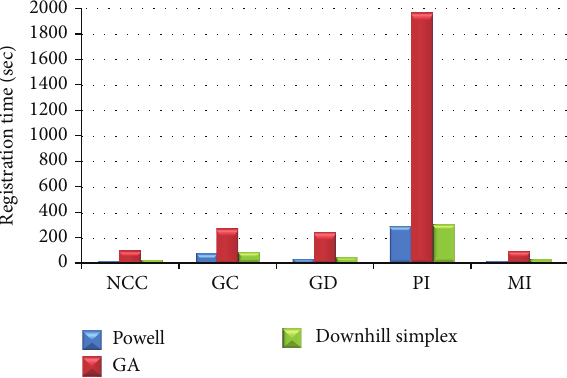
Figure 13: Registration time (sec) of fifteen